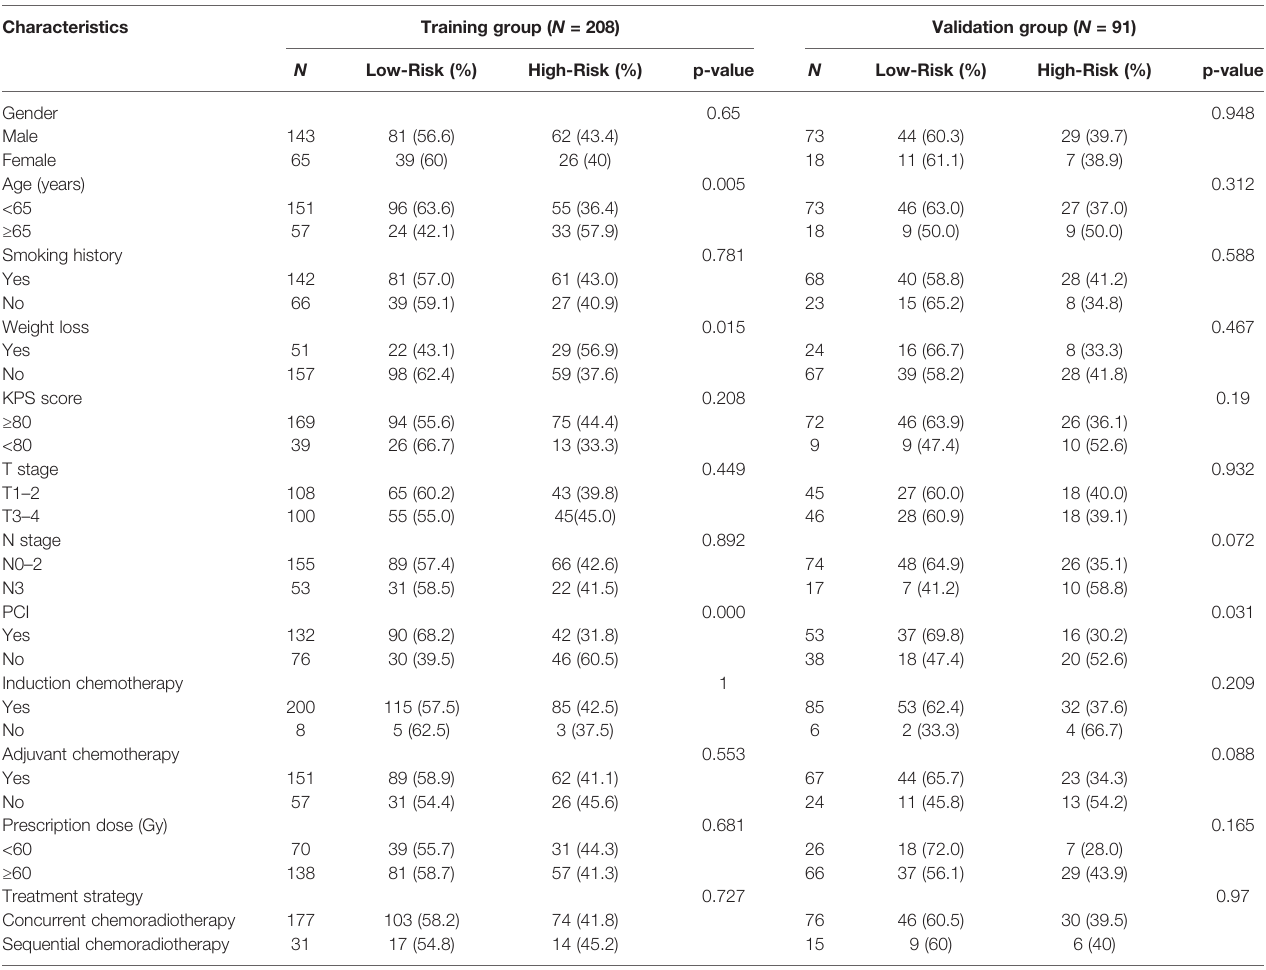
TABLE 3 | Comparison of clinical characteristics of patients dichotomized by the Risk in the training and validation groups. Characteristics Training group ( N = 208) Validation group ( N =